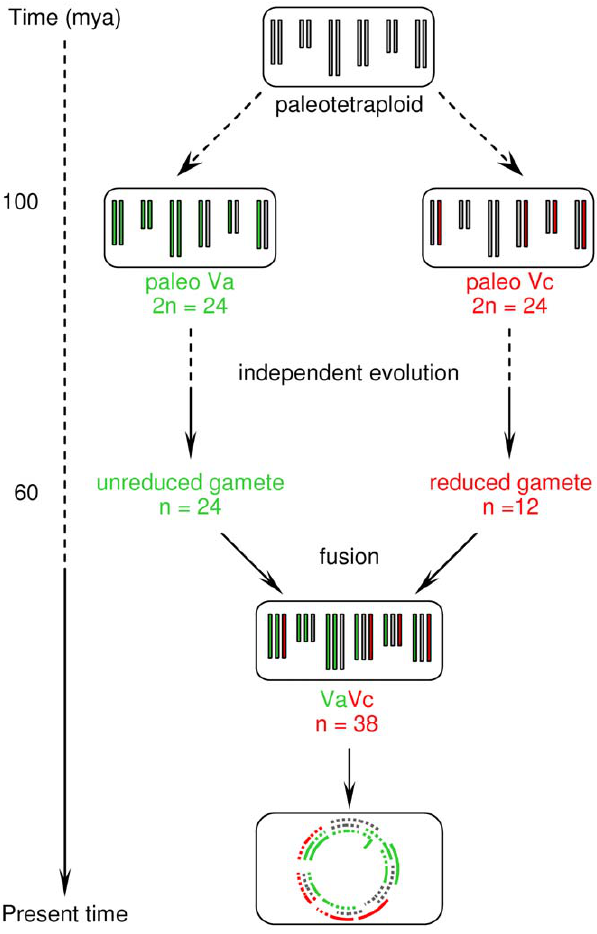
Figure 5. Hypothesized time of events for the evolution of the Vitis genome. The evolution of this genome is proposed to have followed two steps leading to hexaploidisation starting from a paleotetraploid state. In the text, a second scenario is discussed in light of the cytological data for the Rosa canina . The same two steps can be hypothesised, with Va and Vc genomes first coexisting in the same nucleus but not exchanging genetic material, and later fusing to generate the hexaploid state. In such a case, polyploidization probably occurred at an intermediate time between 100 and 60 mya.